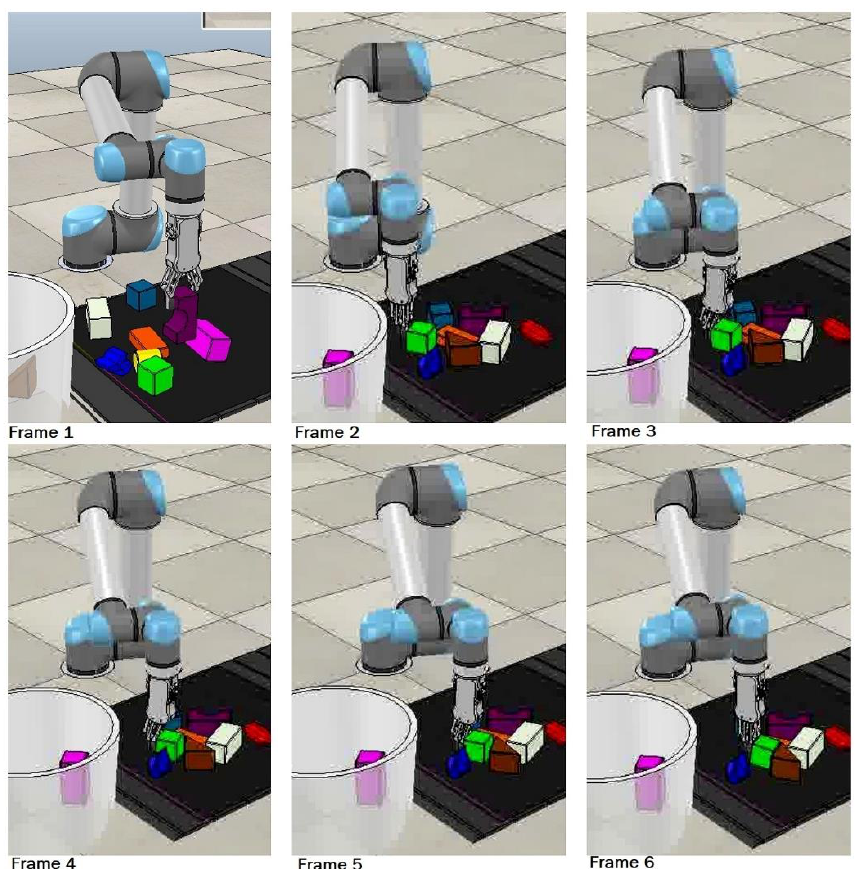
Figure 5. Frame 1 shows the grasping action whereas Frame 2 to Frame 6 show the sliding action being performed on the green square object.